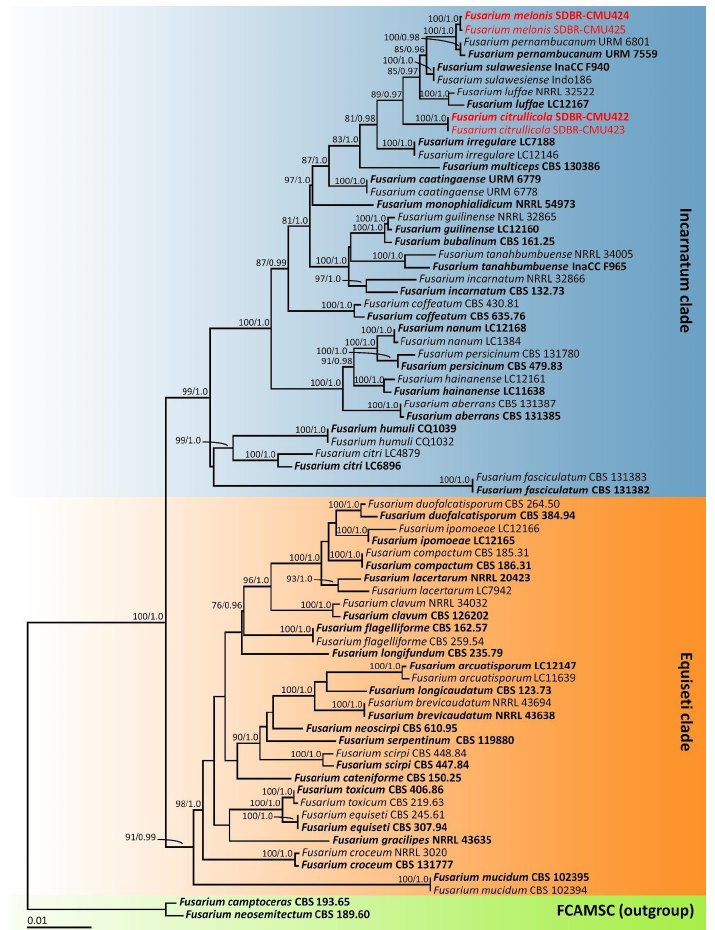
Figure 2. Phylogram derived from maximum likelihood analysis of 73 taxa of the combined tef-1 , cam, and rpb2 sequences. Fusarium camptoceras CBS 193.65 and F. neosemitectum CBS 115476 were used as the outgroup. The numbers above branches represent bootstrap percentages ( left ) and Bayesian posterior probabilities ( right ). Bootstrap values ≥ 75% and Bayesian posterior probabilities ≥ 0.95 are shown. The scale bar represents the expected number of nucleotide substitutions per site. Sequences of fungal species obtained in this study are in red. Type species are in bold.